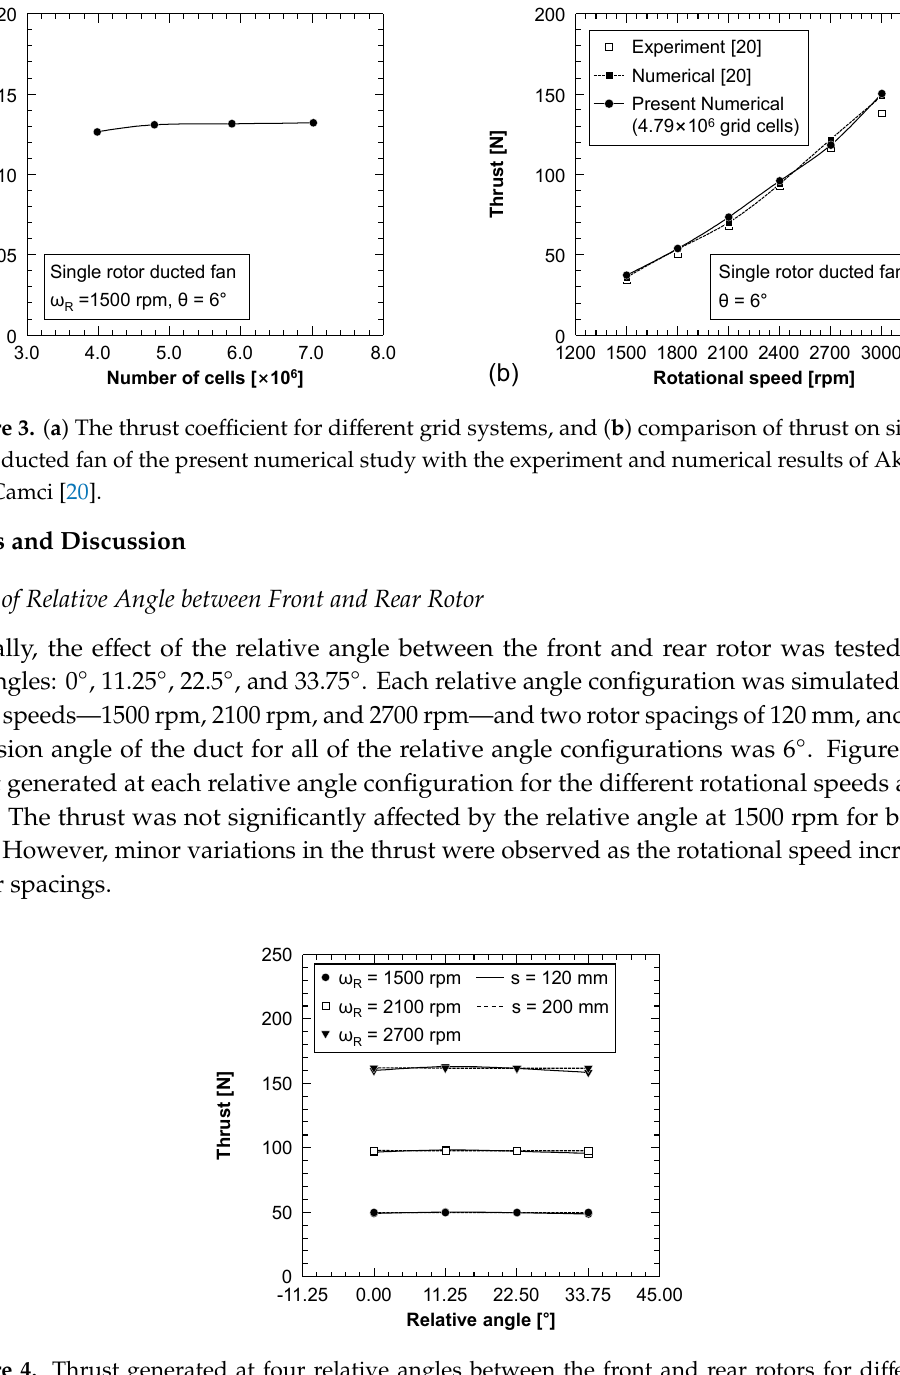
Figure 4. Thrust generated at four relative angles between the front and rear rotors for different rotational speeds and rotor spacings.